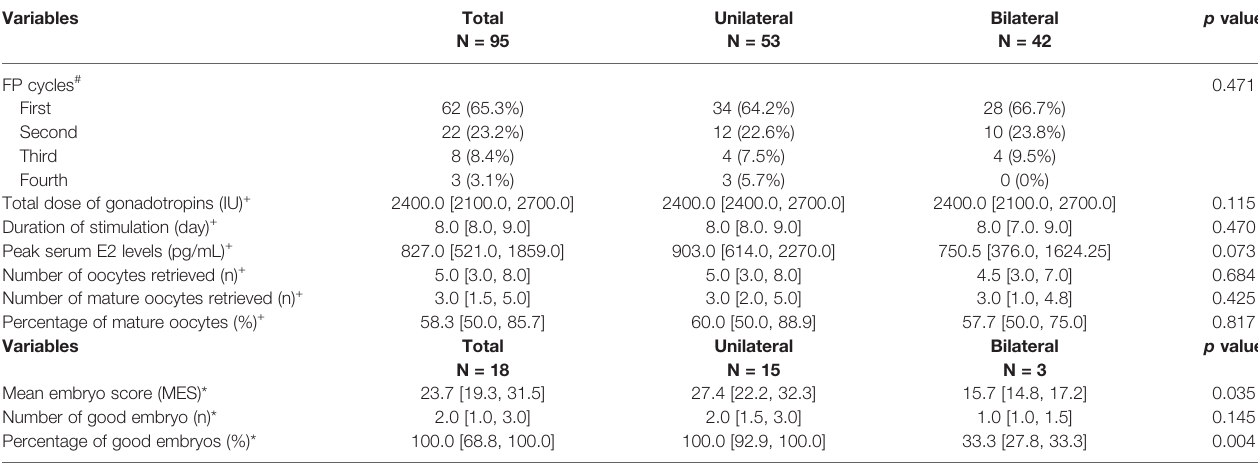
TABLE 2 | Controlled ovarian stimulation outcomes of the patients with endometrioma according to endometrioma laterality. Variables